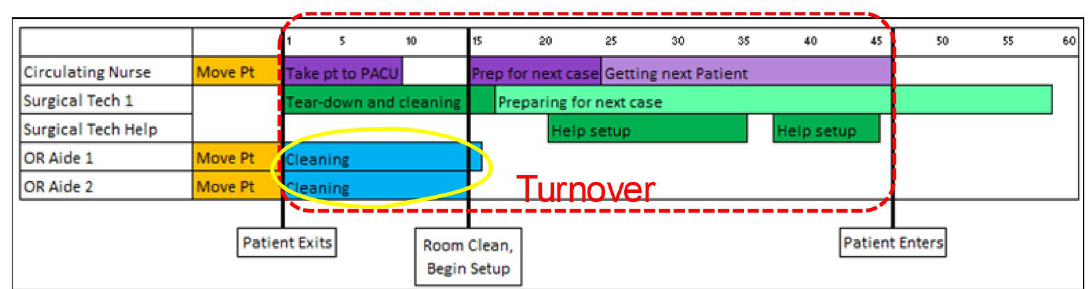
Figure 1. Staff interactions during a